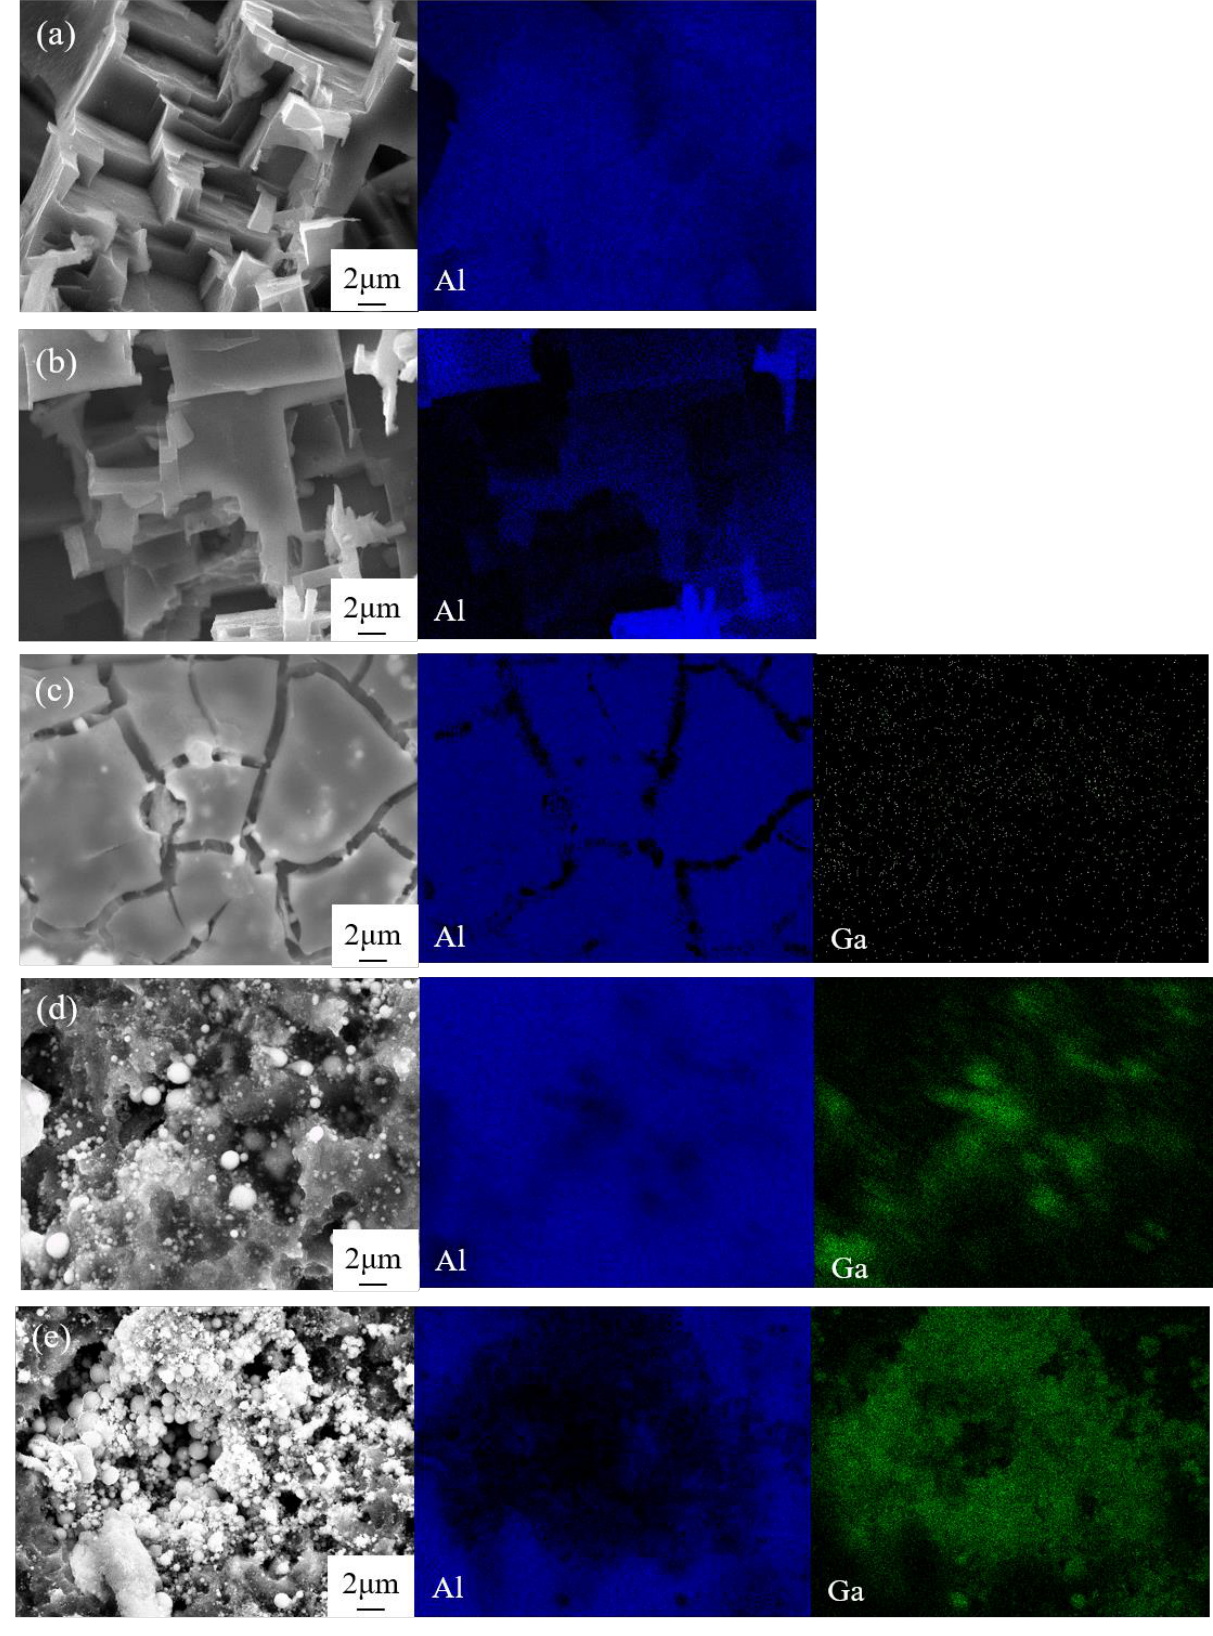
Figure 5. The elemental distribution of Al anode after discharge at 10 mA cm −2 for 2 h in 2 M NaCl electrolyte ( a ) without and with different contents of GaCl 3 : ( b ) 0.05 M, ( c ) 0.1 M, ( d ) 0.15 M, and ( e ) 0.2 M.